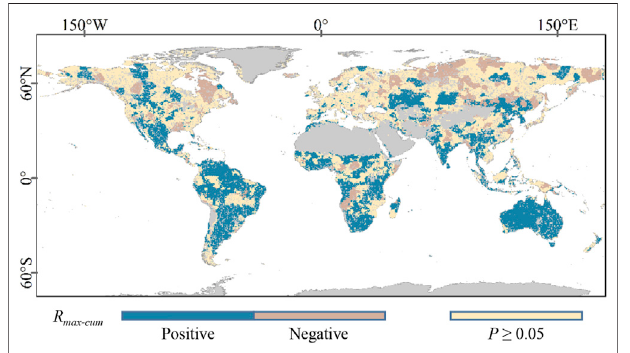
FIGURE2| Spatialdistributionof R max-cum basedonprobabilitystatistic. FIGURE 3 | Spatial distribution of accumulated months based on